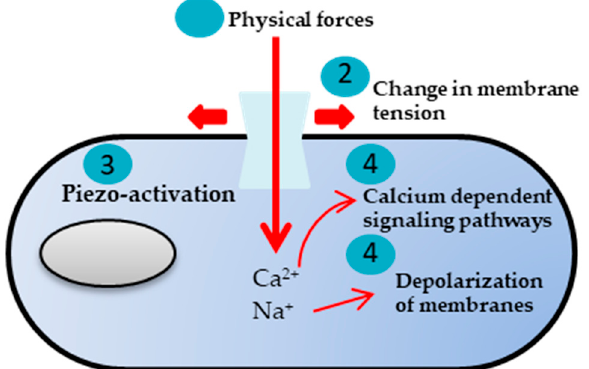
Figure 1. Various mechanical stimuli exerted on the cell induce changes in plasma membrane tension, eliciting piezo-channel openings (adapted from [59]).